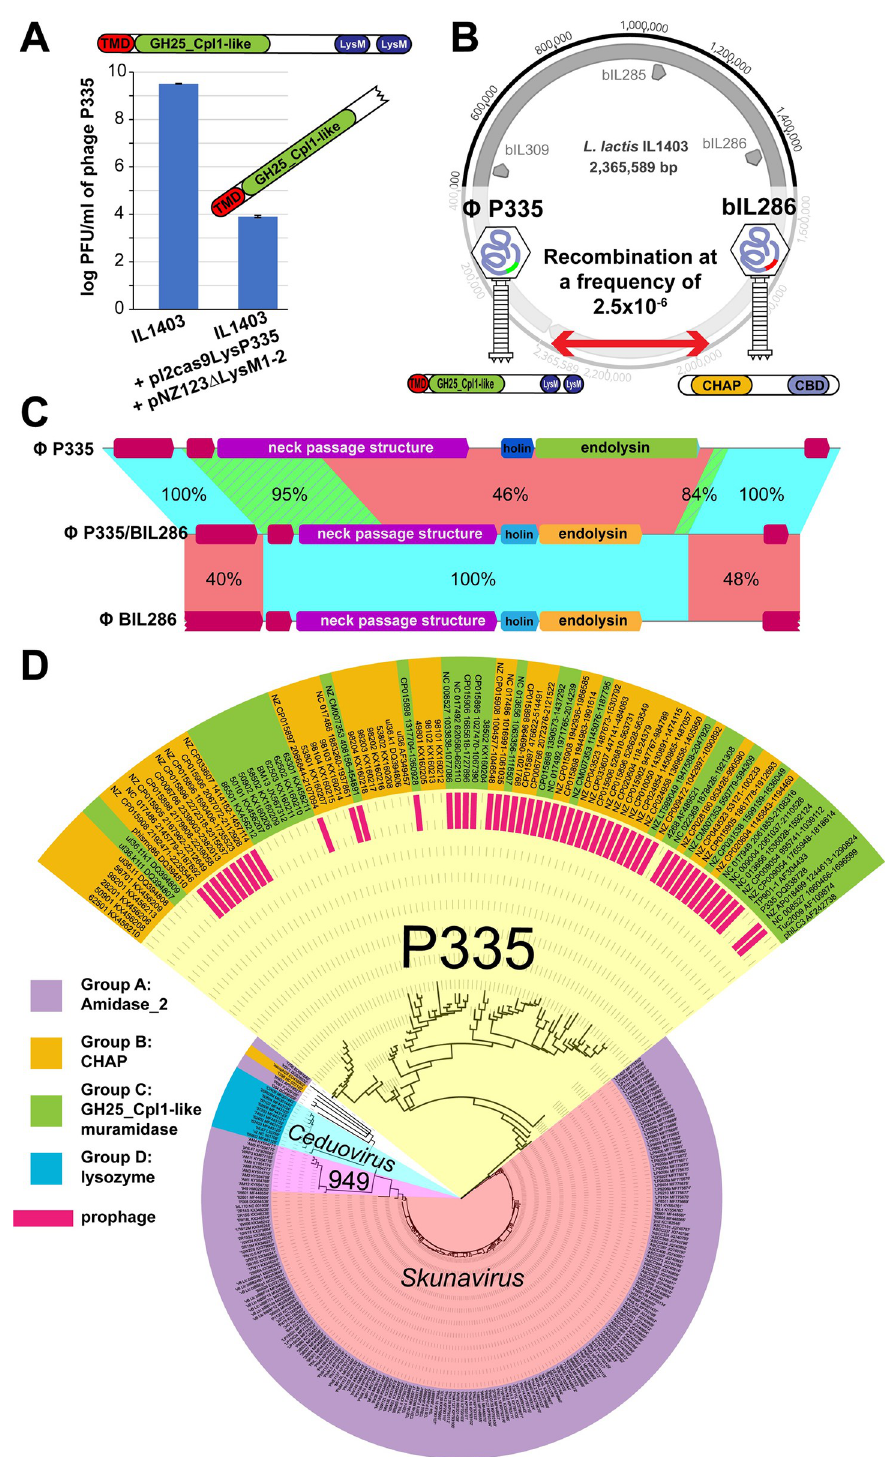
Fig 5. Exchange of endolysin-coding genes by homologous recombination between different phages. (A) Phage P335 was titered on the host strain L . lactis IL1403 and on the phage-resistant L . lactis IL1403 + pL2Cas9 LysP335 + pNZ123 Lys Δ M1–2 (S1 Data). (B) Graphical representation of the prophages integrated in the genome of L . lactis IL1403 and the recombination event that took place between the virulent phage P335 and prophage bIL286. ( C) Graphical representation of the genomic region exchanged between P335 and bIL286 and includes part of the